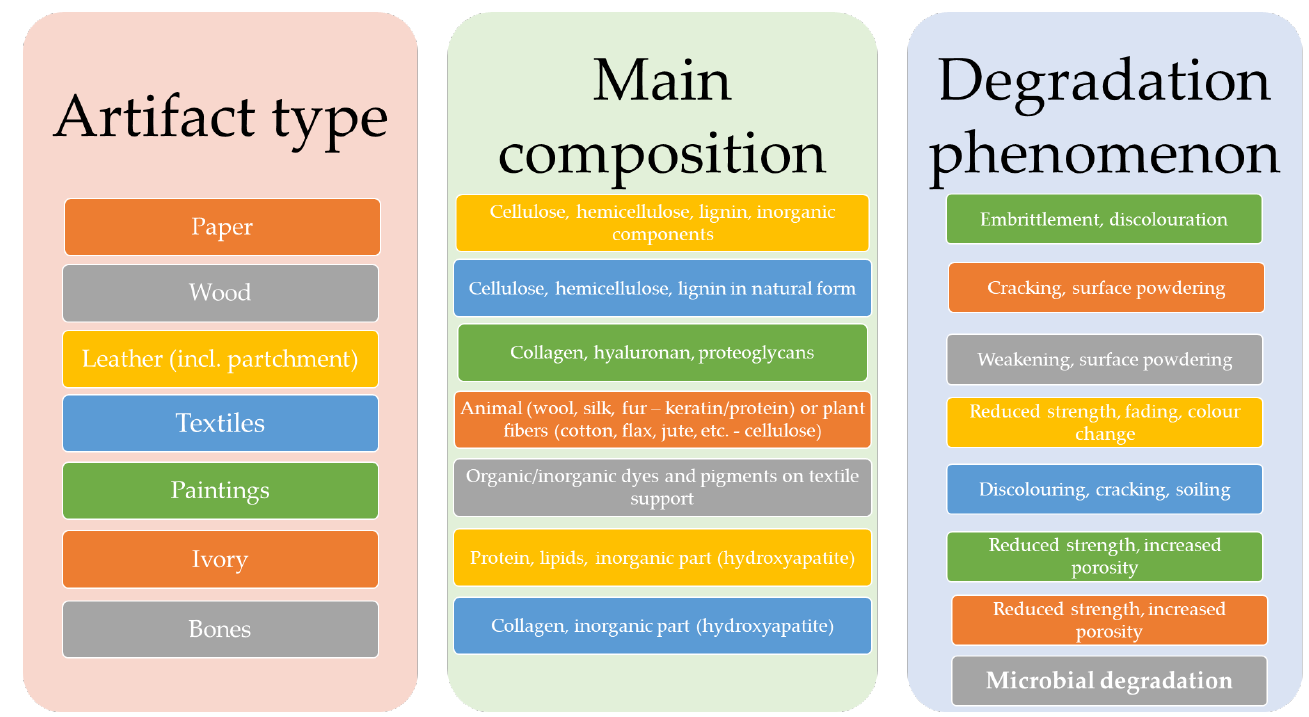
Figure 1. Main types of organic artifacts and their most encountered degradation